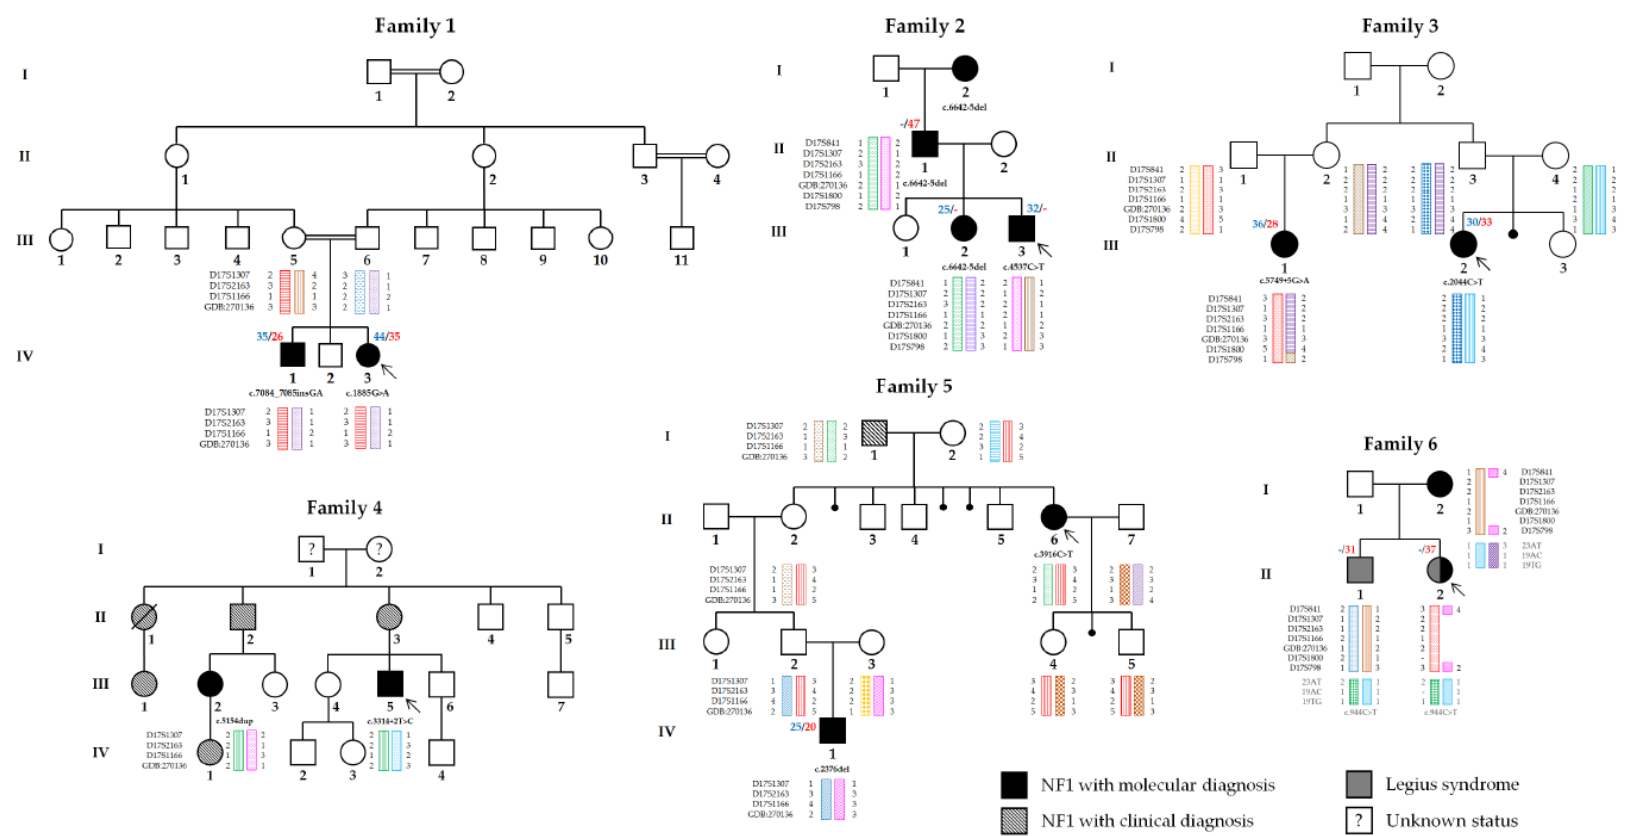
Figure 1. Pedigrees of the six NF1 families. NF1 patients with molecular diagnosis, relatives reported as presenting a NF1 phenotype, and patients with a Legius syndrome are shown in black, black crosshatching, and gray, respectively. Haplotypes for the NF1 and SPRED1 loci are depicted for the corresponding patients. Arrows indicate the propositus in each family. Paternal and maternal ages at conception are indicated above the patient in blue and red, respectively, when available.